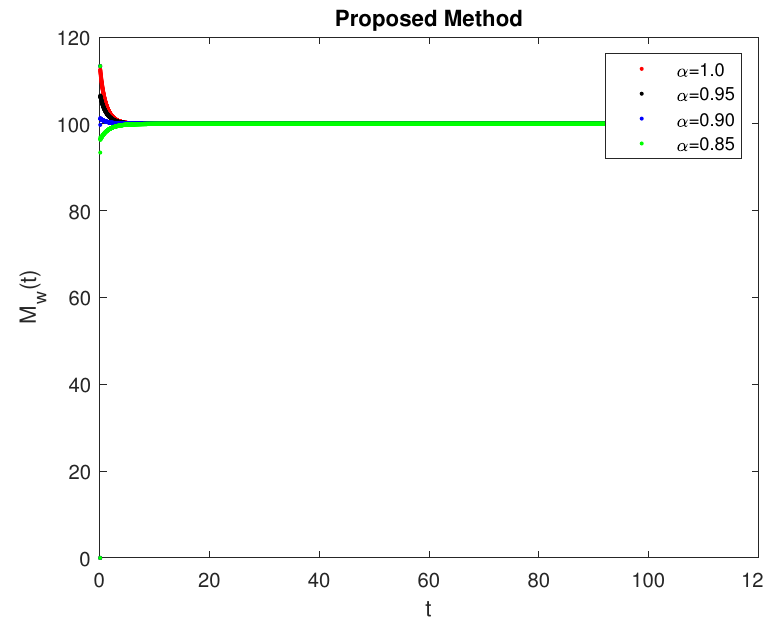
Figure 27: Numerical simulations for τ = 0.9 for Caputo-Fabrizio derivative.